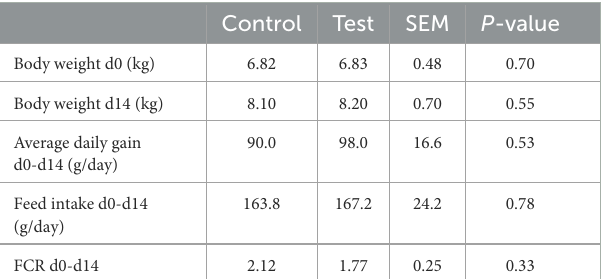
TABLE 3 Performance of piglets fed a control diet (Control; n = 10) or a diet containing 2 kg/ton specific fiber fractions derived from Araceae root and citrus (Test; n = 10) from d0-d14 post-weaning.